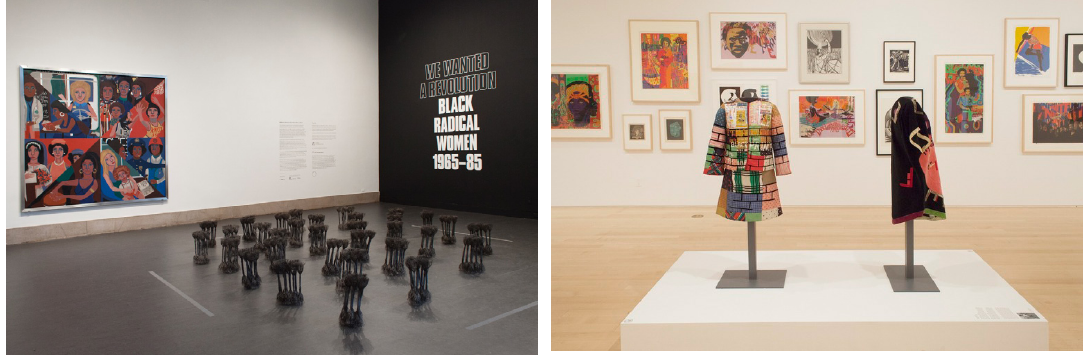
Figure 1. Brooklyn Museum. Digital Collection and Services. We Wanted a Revolution: Black Radical Women , 1965-85. [04/21/2017-09/17/2017]. Installation view.